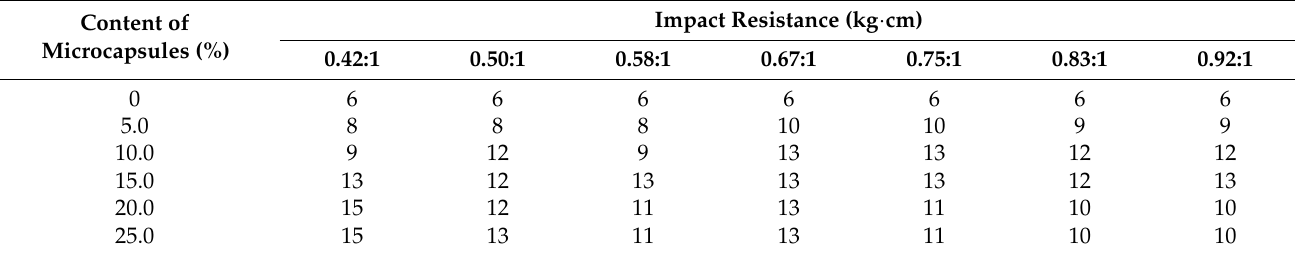
Table 5. Variation of impact resistance of water-based topcoat paint film.